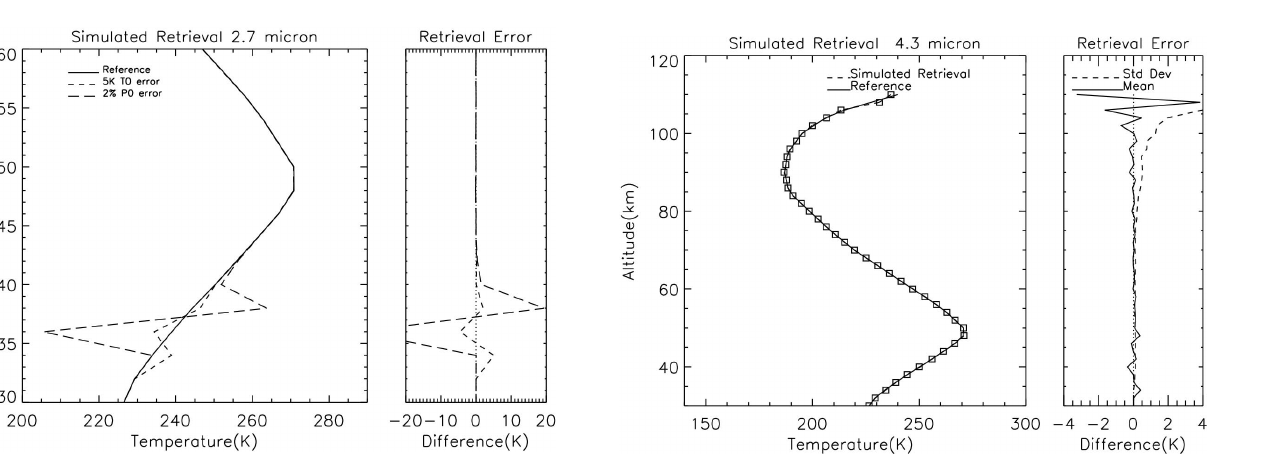
Fig. 11. Simulated temperature retrieval results for the 4.3µm CO 2 band. Right-hand panel shows the mean error and error standard deviation due to 10 − 5 random measurement error on broadband av- eraged transmittance.